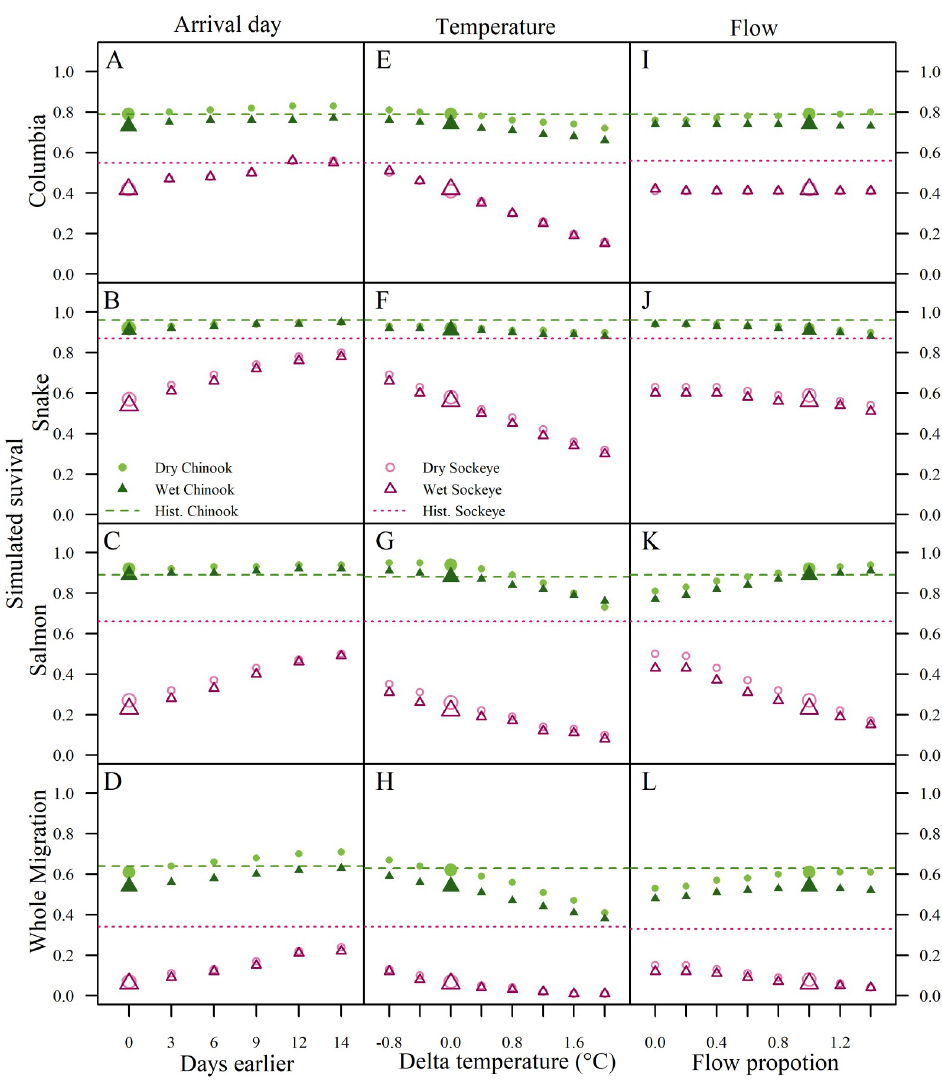
symbols represent the base climate scenario survival predictions with no changes to parameters (Table 4). Horizontal lines show the mean survival rates in the historical climate scenario for each